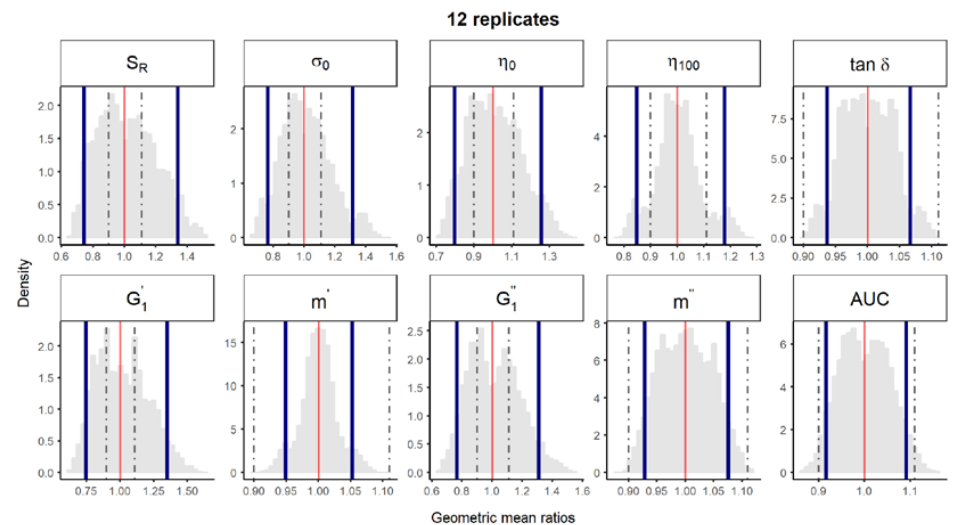
Figure 2. Bootstrap analysis of rheological parameters—1 reference batch versus 1 reference batch. A total of 10,000 geometric mean ratios (light grey area) resulting from the bootstrap analysis of “1 reference batch versus 1 test batch” for each rheological parameter. Data of 10 batches and 12 replicates each were used. Median (red line) and non-parametric 90% CI (blue lines) of the probability distribution. Dashed lines represent the acceptance limits for equivalence (90%–111.11%) stated in the EMA guideline [4]. S R , relative thixotropic area; σ 0 , yield stress; η 0 , zero-shear viscosity; η 100 , viscosity at 100 s − 1 ; tan δ , loss tangent; G (cid:48) , calculated elastic modulus; G (cid:48)(cid:48) , calculated viscous modulus; m’ and m ” are the parameters obtained when fitting G’ and G’’, respectively, versus frequency; AUC, area under the surface versus weight curve (spreadability).